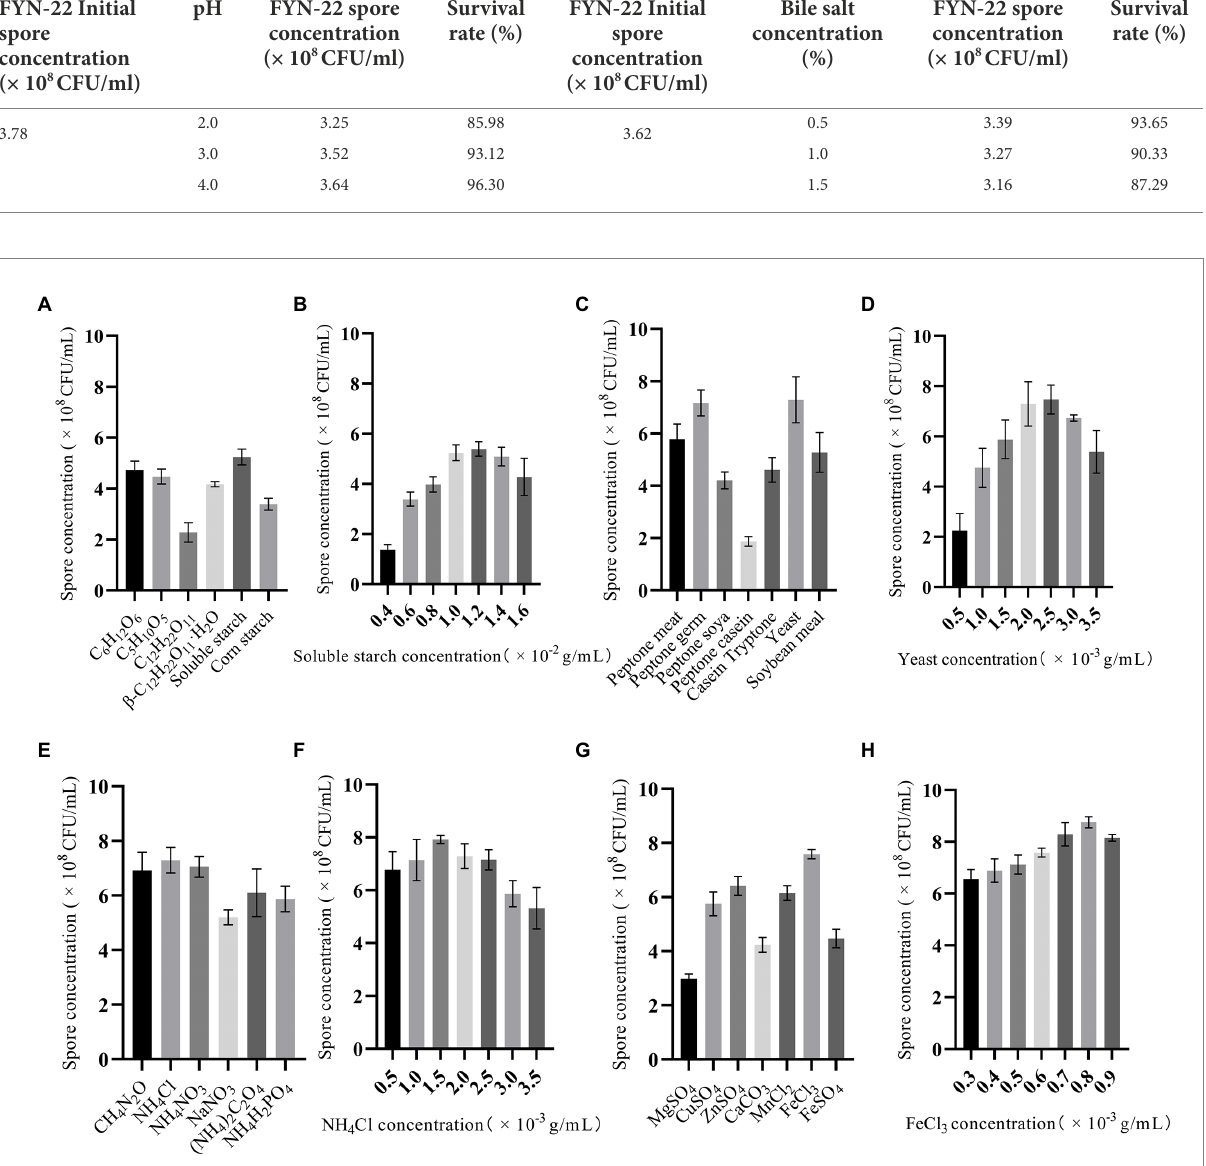
FIGURE 2 Effect of OFAT optimized carbon source composition (A) , soluble starch concentration (B) , organic nitrogen source composition (C) , yeast concentration (D) , inorganic nitrogen source composition (E) , NH 4 Cl concentration (F) , inorganic salt composition (G) , and FeCl 3 concentration (H) on the concentration of FYN-22 spores. Error bars indicate standard error ( n =